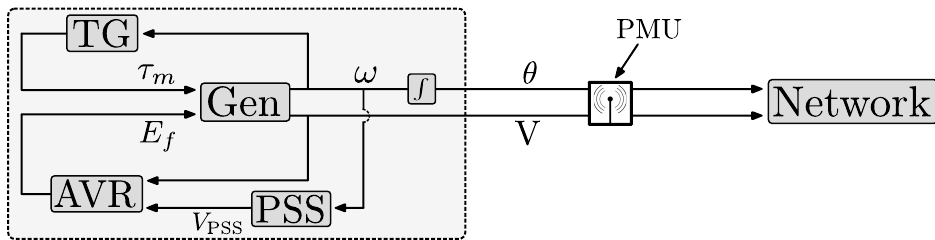
Figure 3. Shown is the interaction between the generator, its three controllers, and the network. The PMU collects data at the generator’s point of